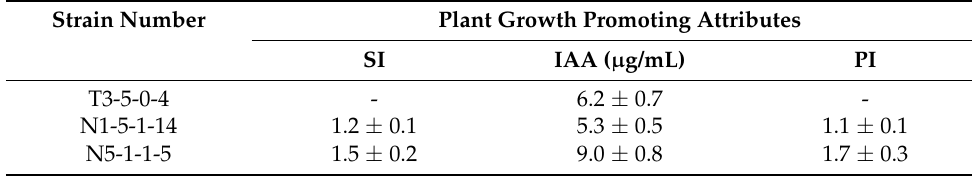
Table 3. Plant growth promoting properties of novel strains. SI, solubilization Index; IAA, indole-3- acetic acid; PI, production